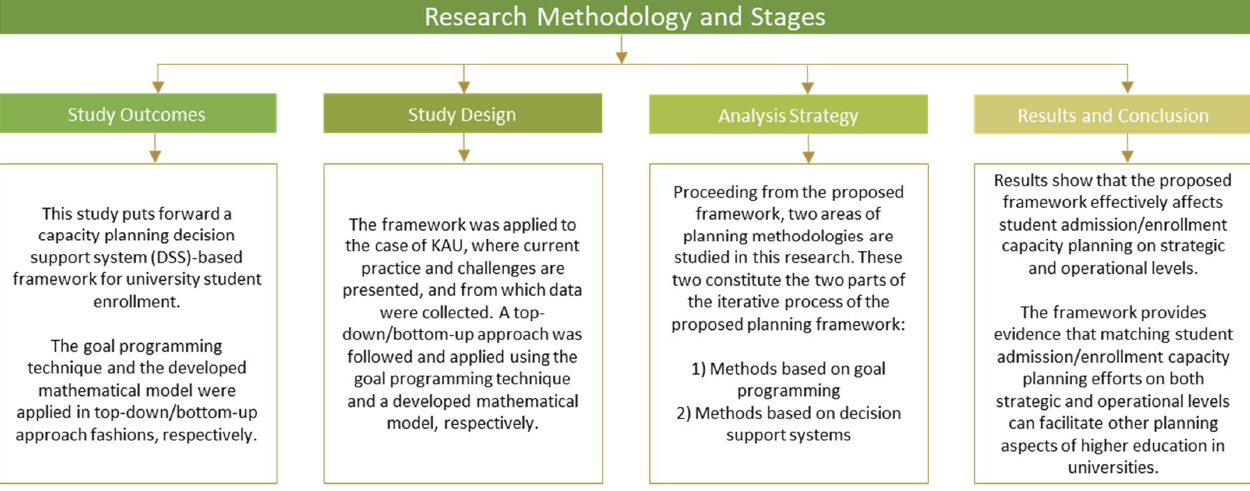
Figure 1. Research methodology and stages.